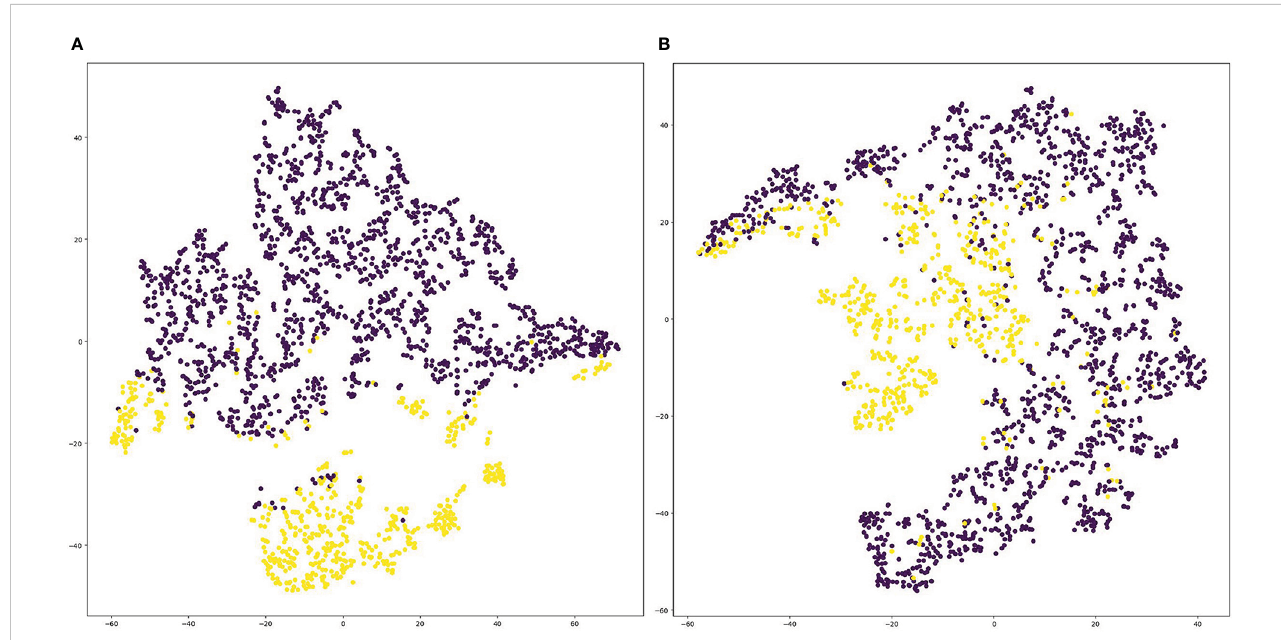
FIGURE 6 Visualization of deep representations from proposed model using t-SNE. Yellow dots represent the distribution of deep representations for positive cases, and purple dots represent the distribution of deep representations for negative cases. (A) denotes PD-1 expression and (B) denotes PD-L1